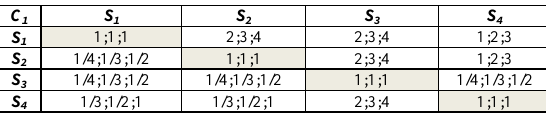
Table 2. Matrix of pairwise comparisons of the sub-criteria in relation to the criterion C